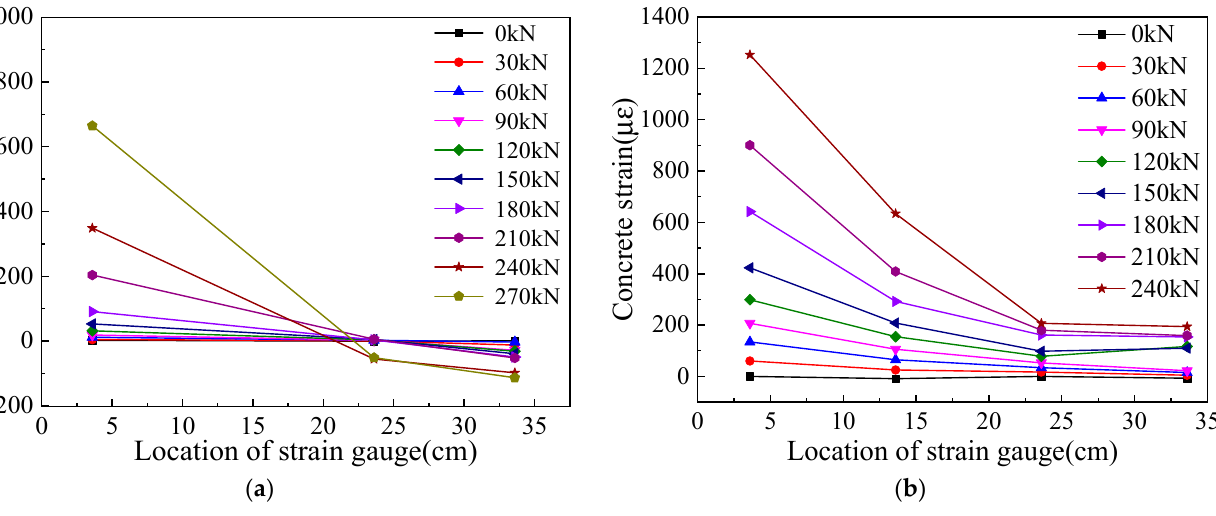
Figure 7. Concrete strain distribution of corbel. ( a ) Corbel normal section. ( b ) Corbel diagonal sec- tion.